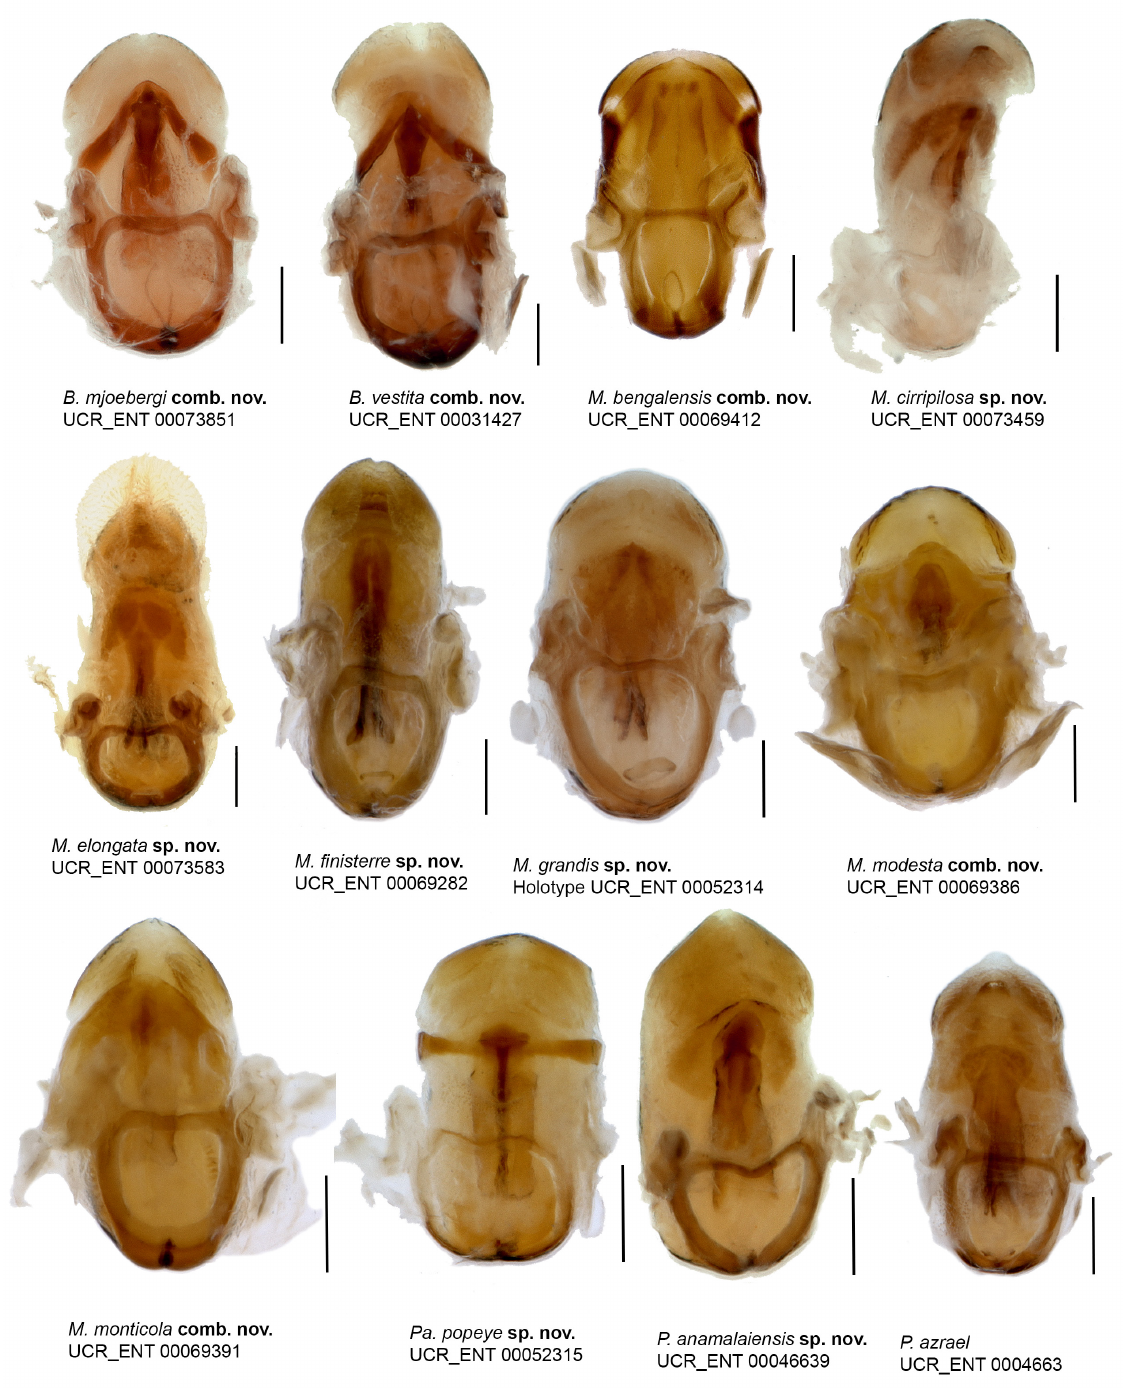
Fig. 9. Dorsal view of the phallus in species of Breviphysoderes gen. nov., Macrophysoderes gen. nov., Paraphysoderes Villiers, 1962 and Physoderes Westwood, 1845 (partial). Scale bars = 0.20